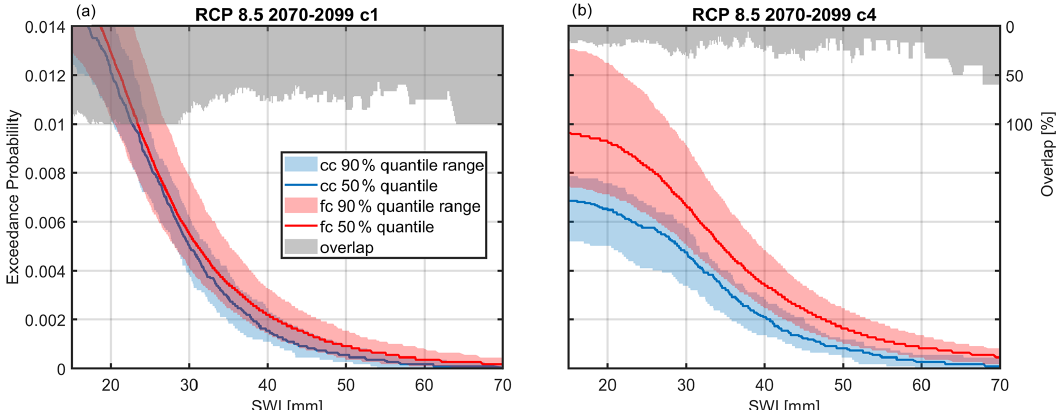
Figure 10. Yearly exceedance probability of total area-averaged SWI of ROS events for current climate (cc) and RCP 8.5 at the end of the century (fc) for (a) criterion 1 (c1) and (b) criterion 4 (c4). A contributing area > 1 / 3 of the total area was chosen to define a ROS event. Plotted are the 5th, 50th and 95th percentiles of climate period mean values stemming from 50 (current climate) and 500 climate periods (future climate with 50 realizations of 10 climate